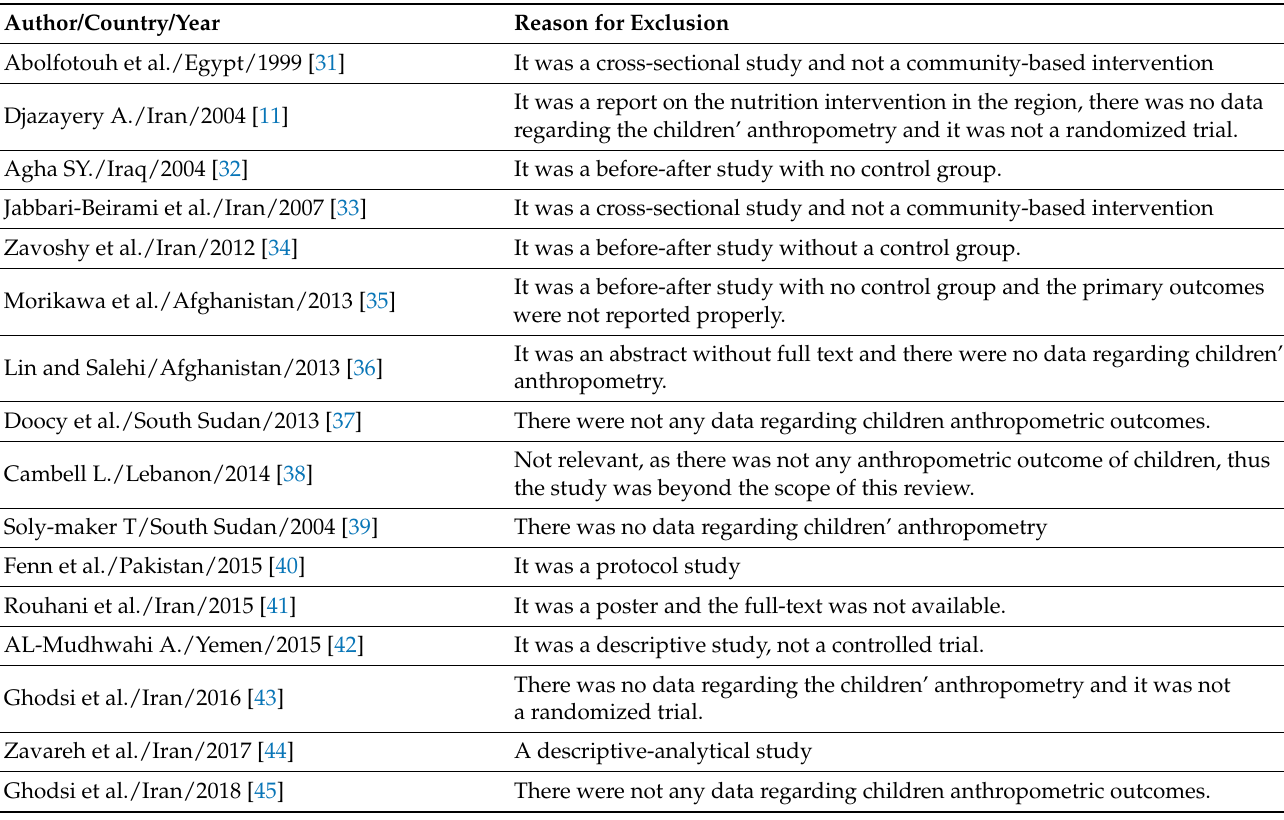
Table 1. List of excluded articles from the systematic review and the reasons.